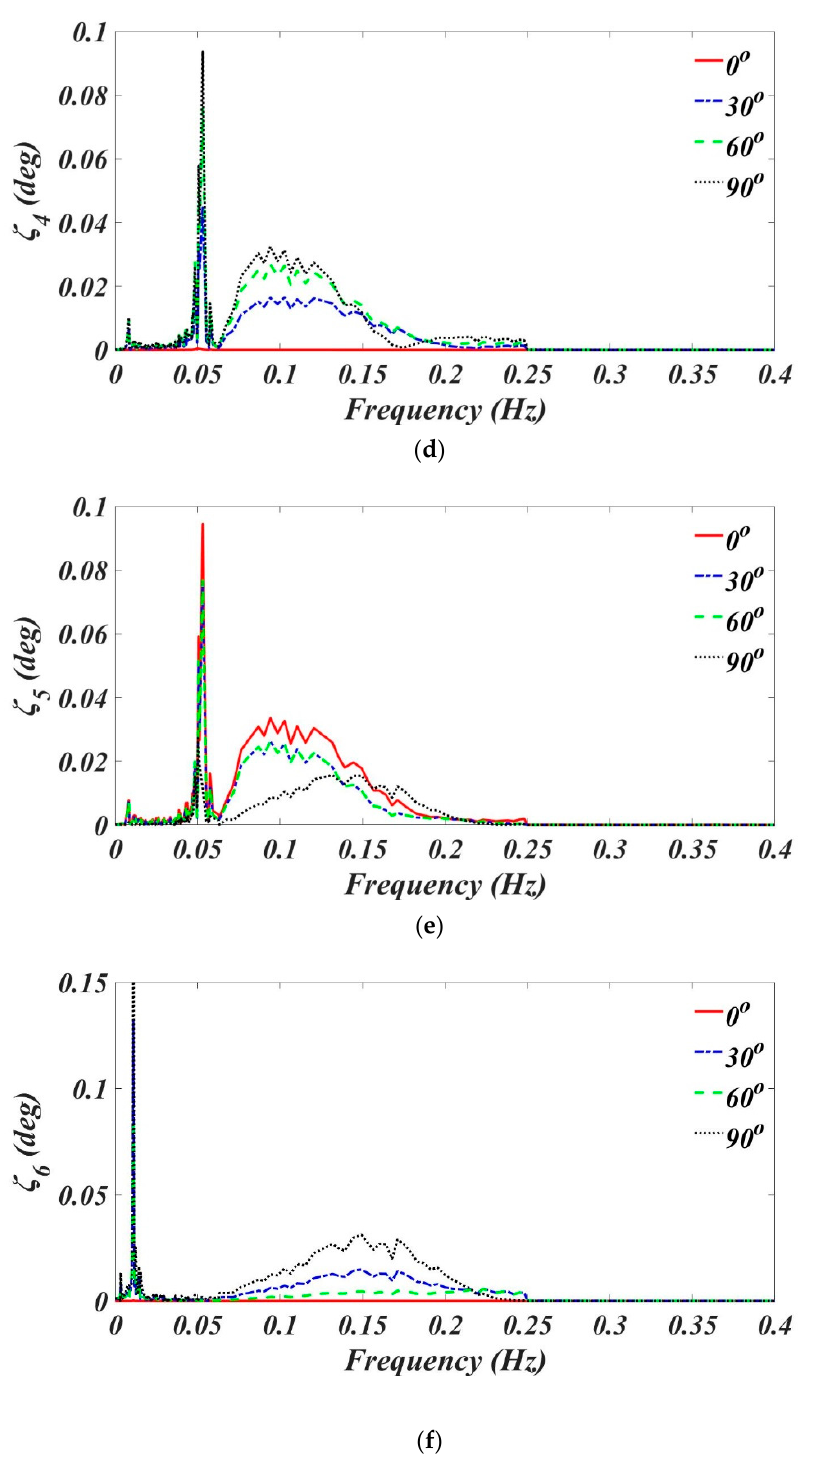
Figure 15. The effects of the wave heading angles on the motion responses in ( a ) the surge, ( b ) the sway, ( c ) the heave, ( d ) the roll, ( e ) the pitch, and ( f ) the yaw modes, respectively.